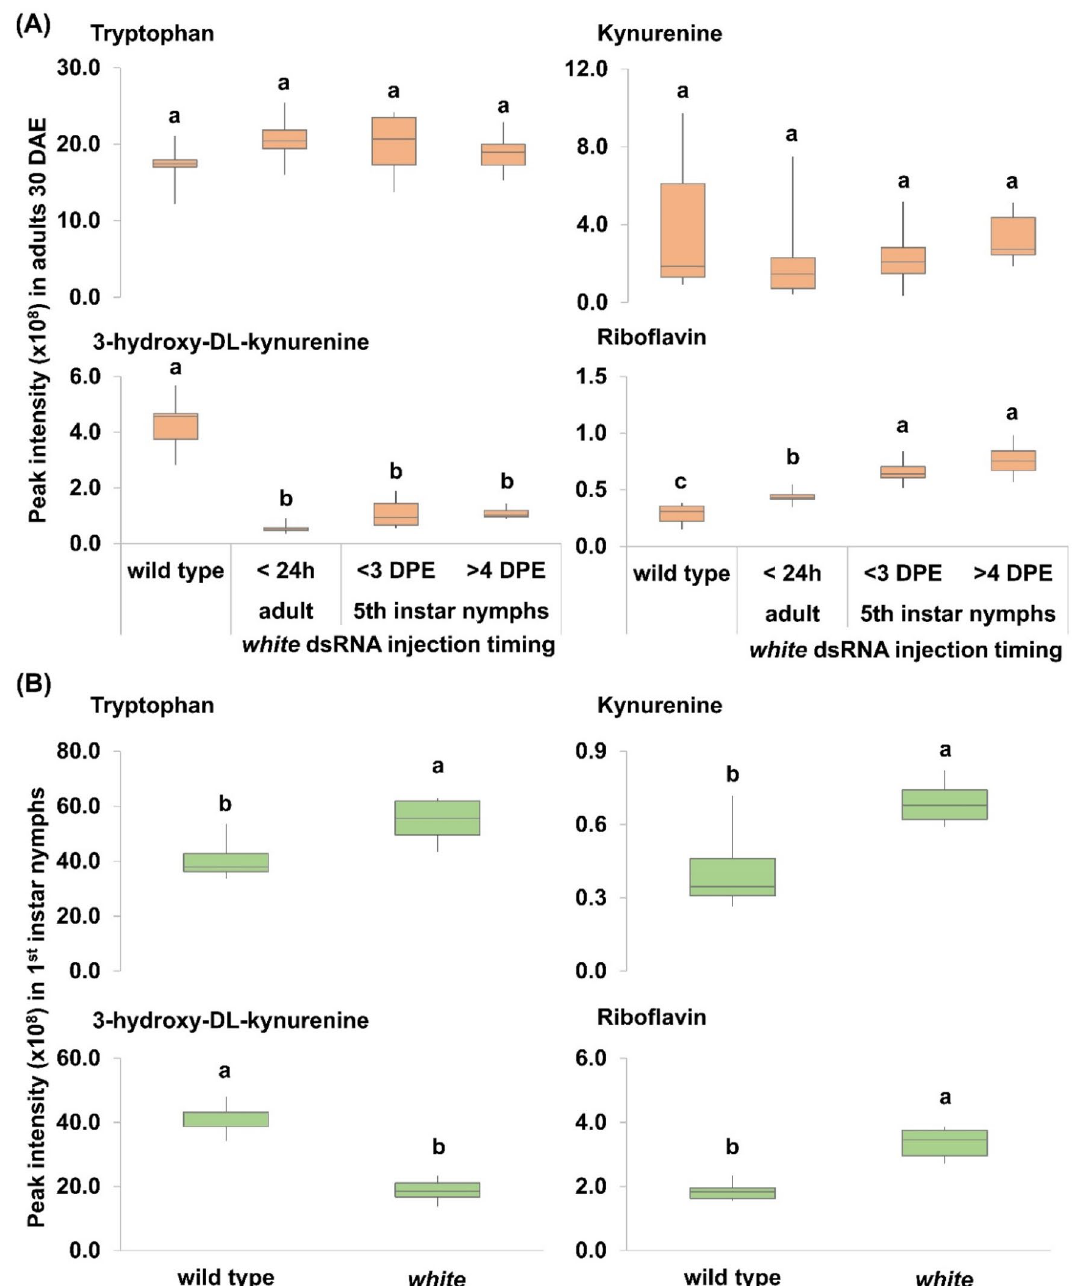
Figure 4. Metabolomic analysis of riboflavin and ommochrome biosynthesis in SGSB comparing white and wild type phenotypes observed during RNAi-based experiments. ( A ) adults at 30 days after emergence (DAE) that were treated with white dsRNA as < 24 h newly emerged adults or as nymphs either at < 3 days prior emergence (DPE) or > 4 DPE. Metabolites measured in adults were: tryptophan ( F ( 3,20 ) = 1.23 ; p = 0.3244 ) ; kynurenine ( F ( 3,20 ) = 0.52 ; p = 0.6754 ) ; 3-hydroxy-DL-kynurenine ( F ( 3,20 ) = 51.25 ; p < 0.0001 ) ; and riboflavin ( F ( 3,20 ) = 23.08 ; p < 0.0001 ) . ( B ) first instar nymphs (< 12 h-old) originated from mothers treated with white dsRNA at < 24 h adult stage. Metabolites measured in first instar nymphs were: tryptophan ( t ( 10 ) = 3.21 ; p = 0.0093 ) ; kynurenine ( t ( 10 ) = 3.51 ; p = 0.0056 ) ; 3-hydroxy-DL-kynurenine ( t ( 10 ) = 9.25 ; p < 0.0001 ) ; and riboflavin ( t ( 10 ) = 6.46 ; p < 0.0001 ) . Treatment means followed by the same letter were not statistically different (Fisher’s LSD test, α =